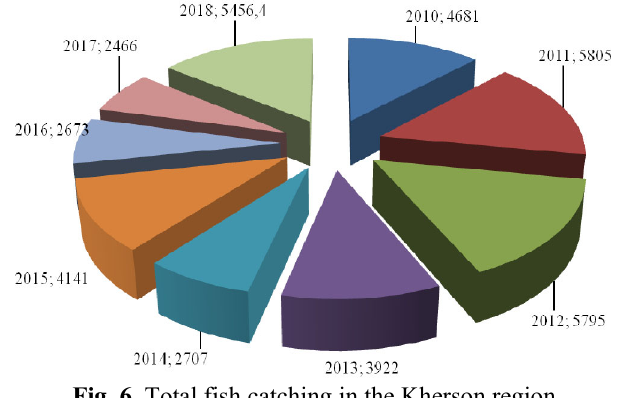
Fig. 6. Total fish catching in the Kherson